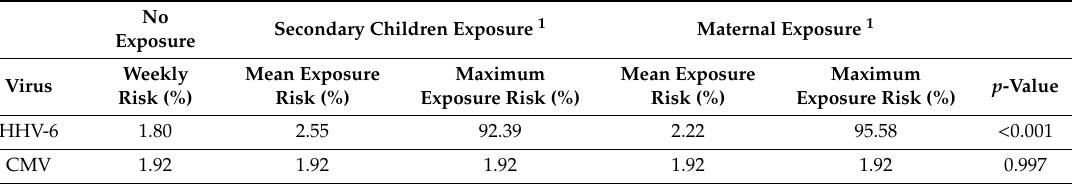
1 Mean and maximum exposures (DNA copies / mL) shown in Table 1.